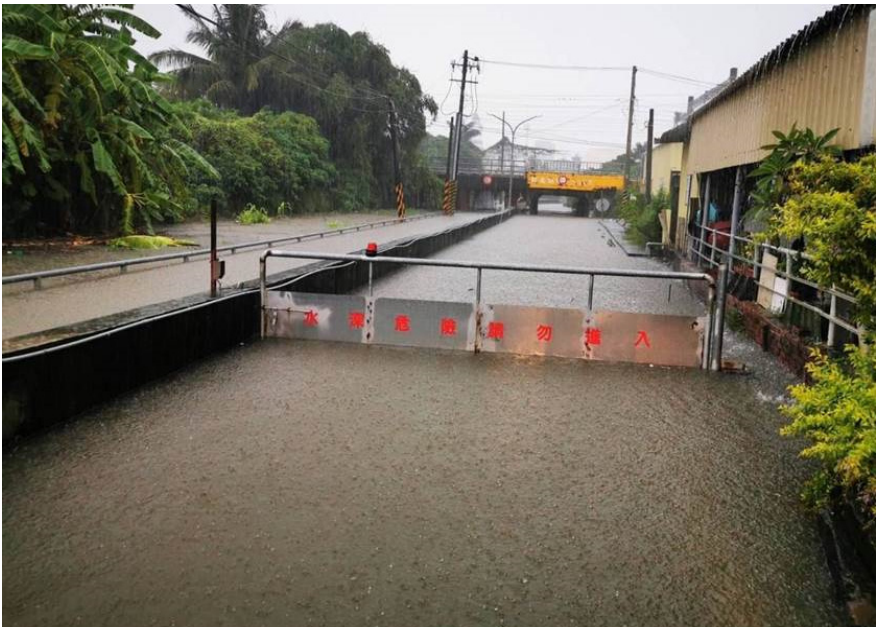
Figure 2. A severe pluvial flash flood in Tainan caused by torrential rainfall on 26 August 2020. (Photo by the authors of the present study).